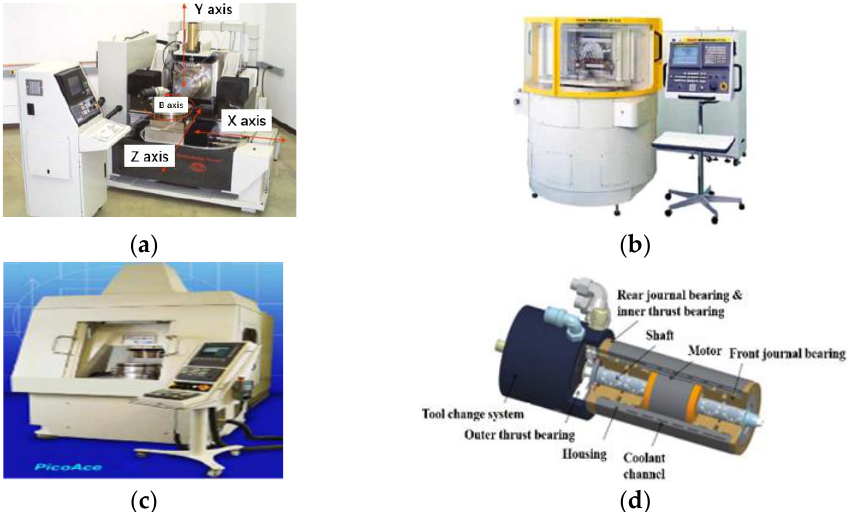
Figure 1. ( a ) Nanotech 500FG. Reprinted with permission from ref. [5] Copyright 2005 Elsevier; ( b )